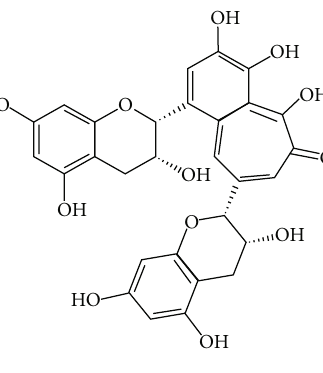
Figure 8: Molecular graph of thea fl avin.